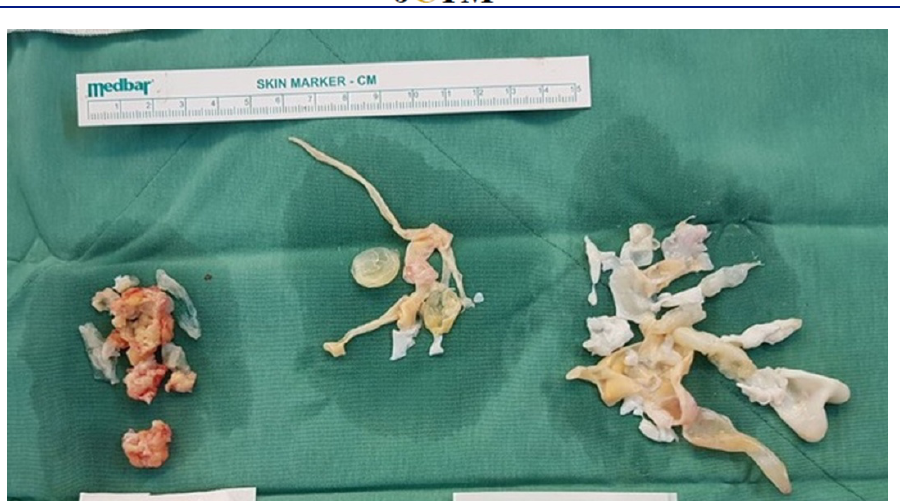
Figure 2. Intra-atrial, intra-inferior vena cava, and pulmonary artery hydatic cysts hemoptysis 3 days after the surgery. The pulmonary cysts, intra-cardiac cysts, and inferior vena cava cysts were confirmed by pathology examination as hydatid cysts (Figure2). Discussion Echinococcus Embolism caused by spp. is a rare complication and a life-threatening